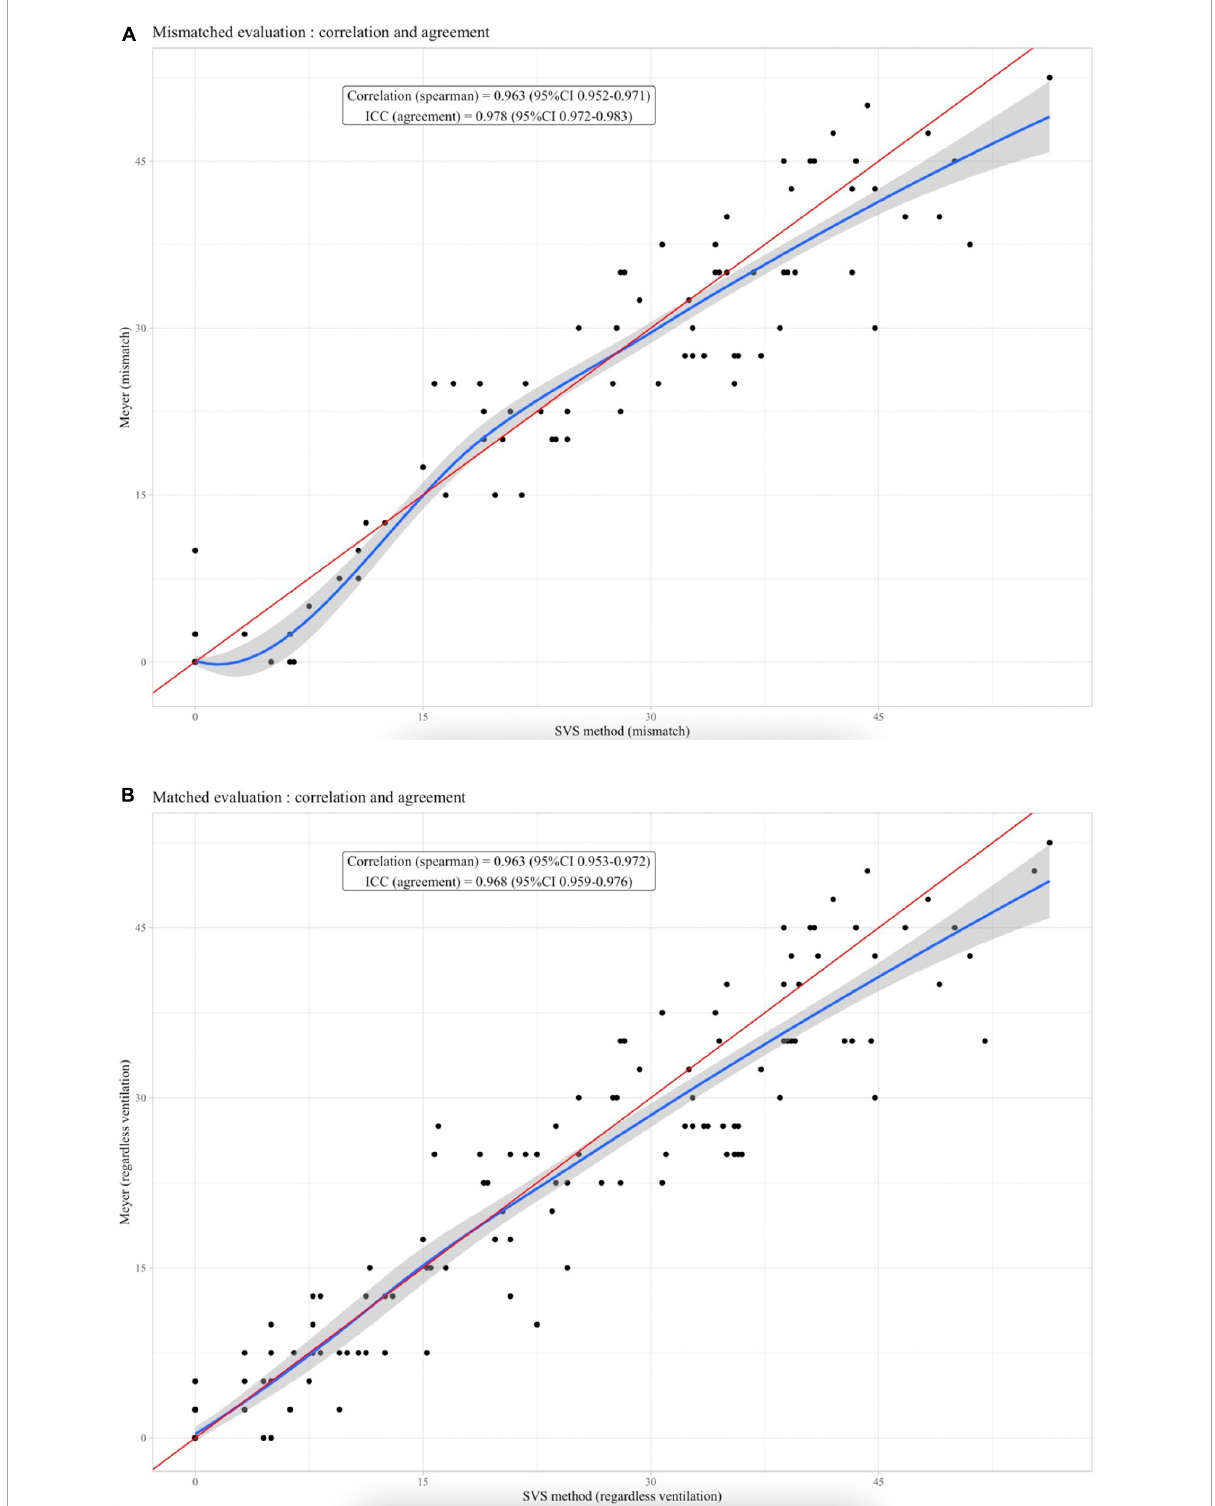
FIGURE1 (A) Plot graph for correlation between SVS method and Meyer score for mismatched perfusion defect. Red line as the line of equality ( r = 1). Blue line as local polynomial regression fitting. (B) Plot graph for correlation between SVS method and Meyer score for perfusion defects regardless ventilation. Red line as the line of equality ( r = 1). Blue line as local polynomial regression